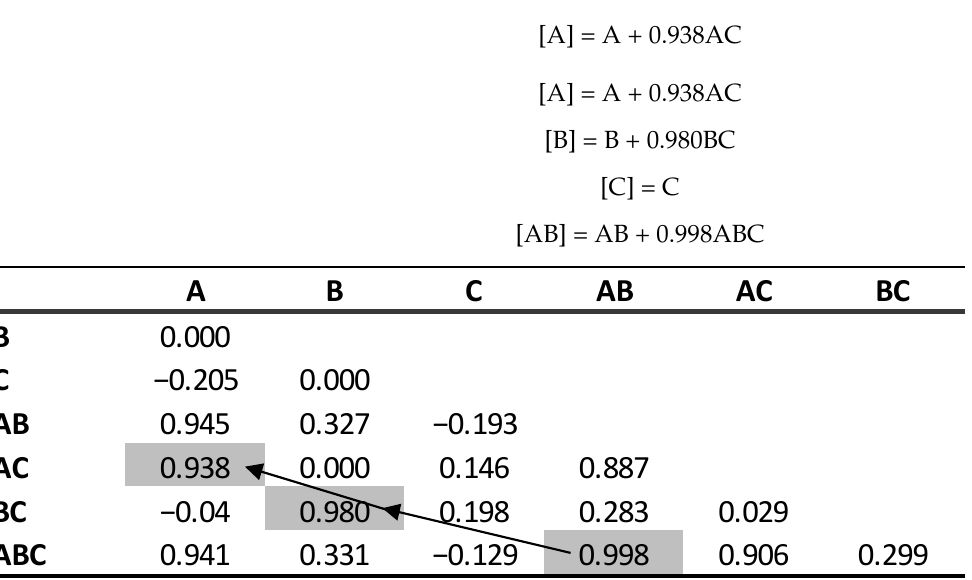
Figure 5. Path followed to construct the alias structure.